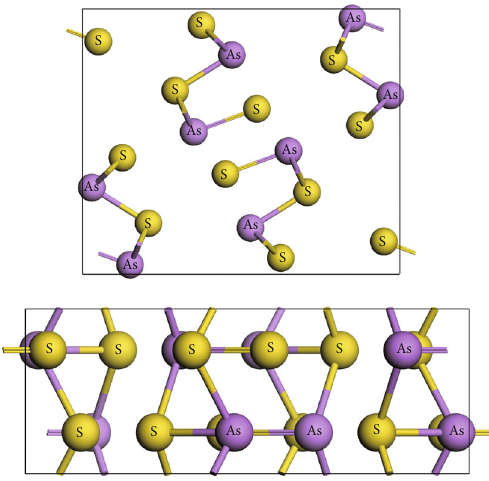
Figure 1: The crystal structure of orpiment As purple atoms represent the S and As elements, respectively.